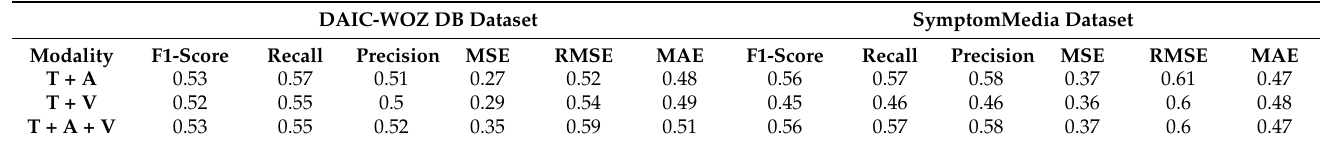
Table 7. Performance and error metrics for the LSTM without gating (T + A: text and audio; T + V: text and video; T + A + V: text, audio, and video). DAIC-WOZ DB Dataset